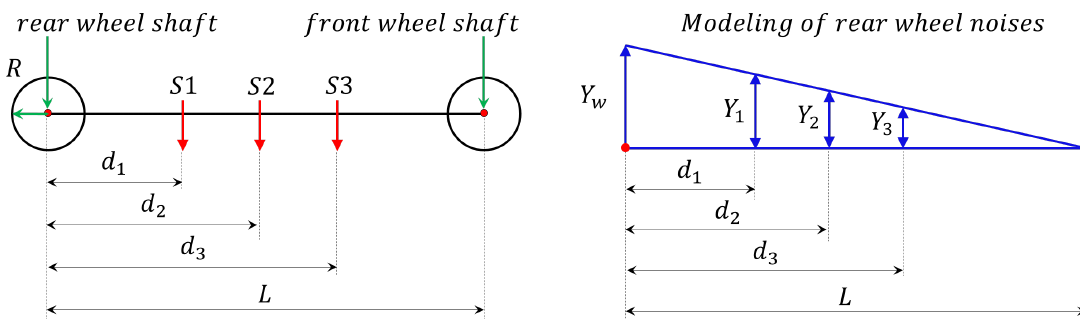
Figure 11. Models of wheel